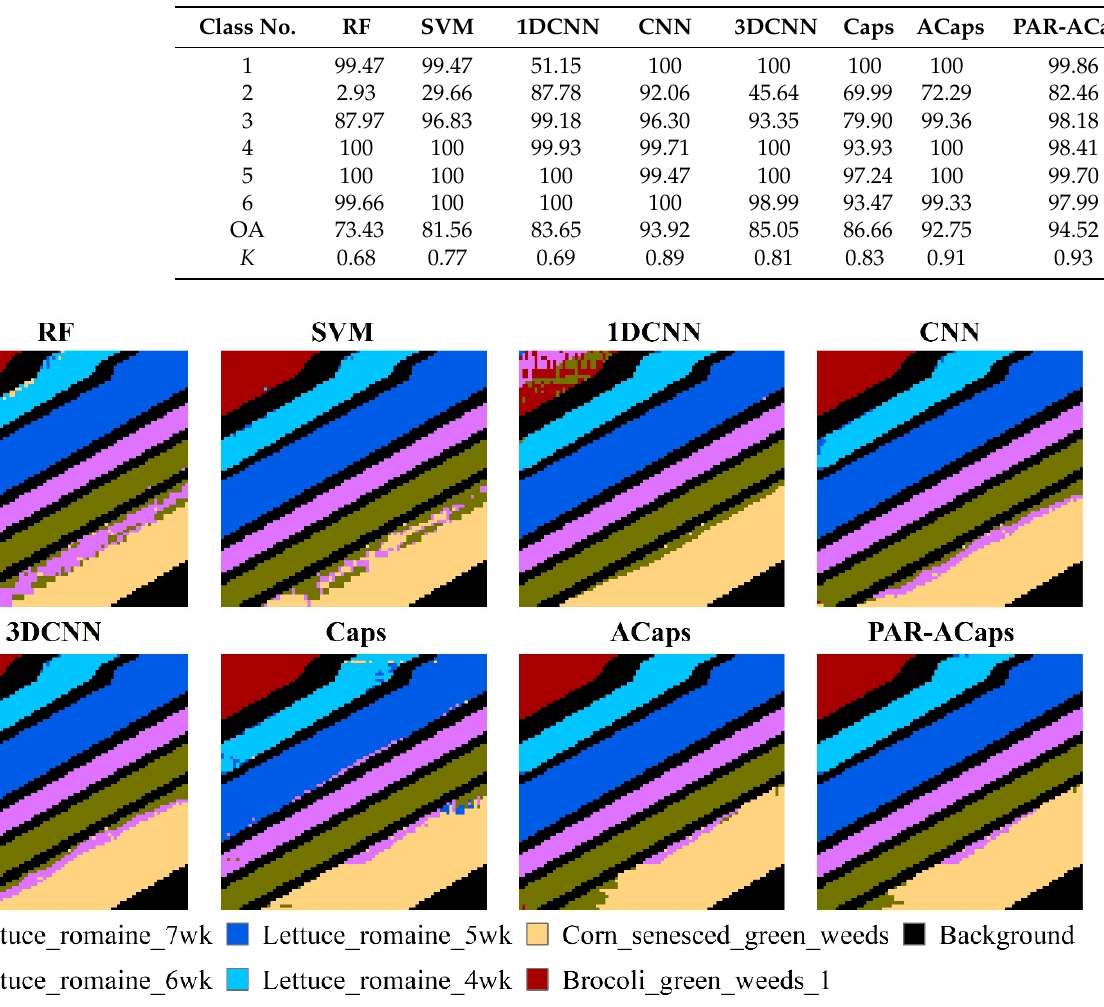
Figure 9. The classification results of SA dataset obtained by the PAR-ACaps and the benchmarks.